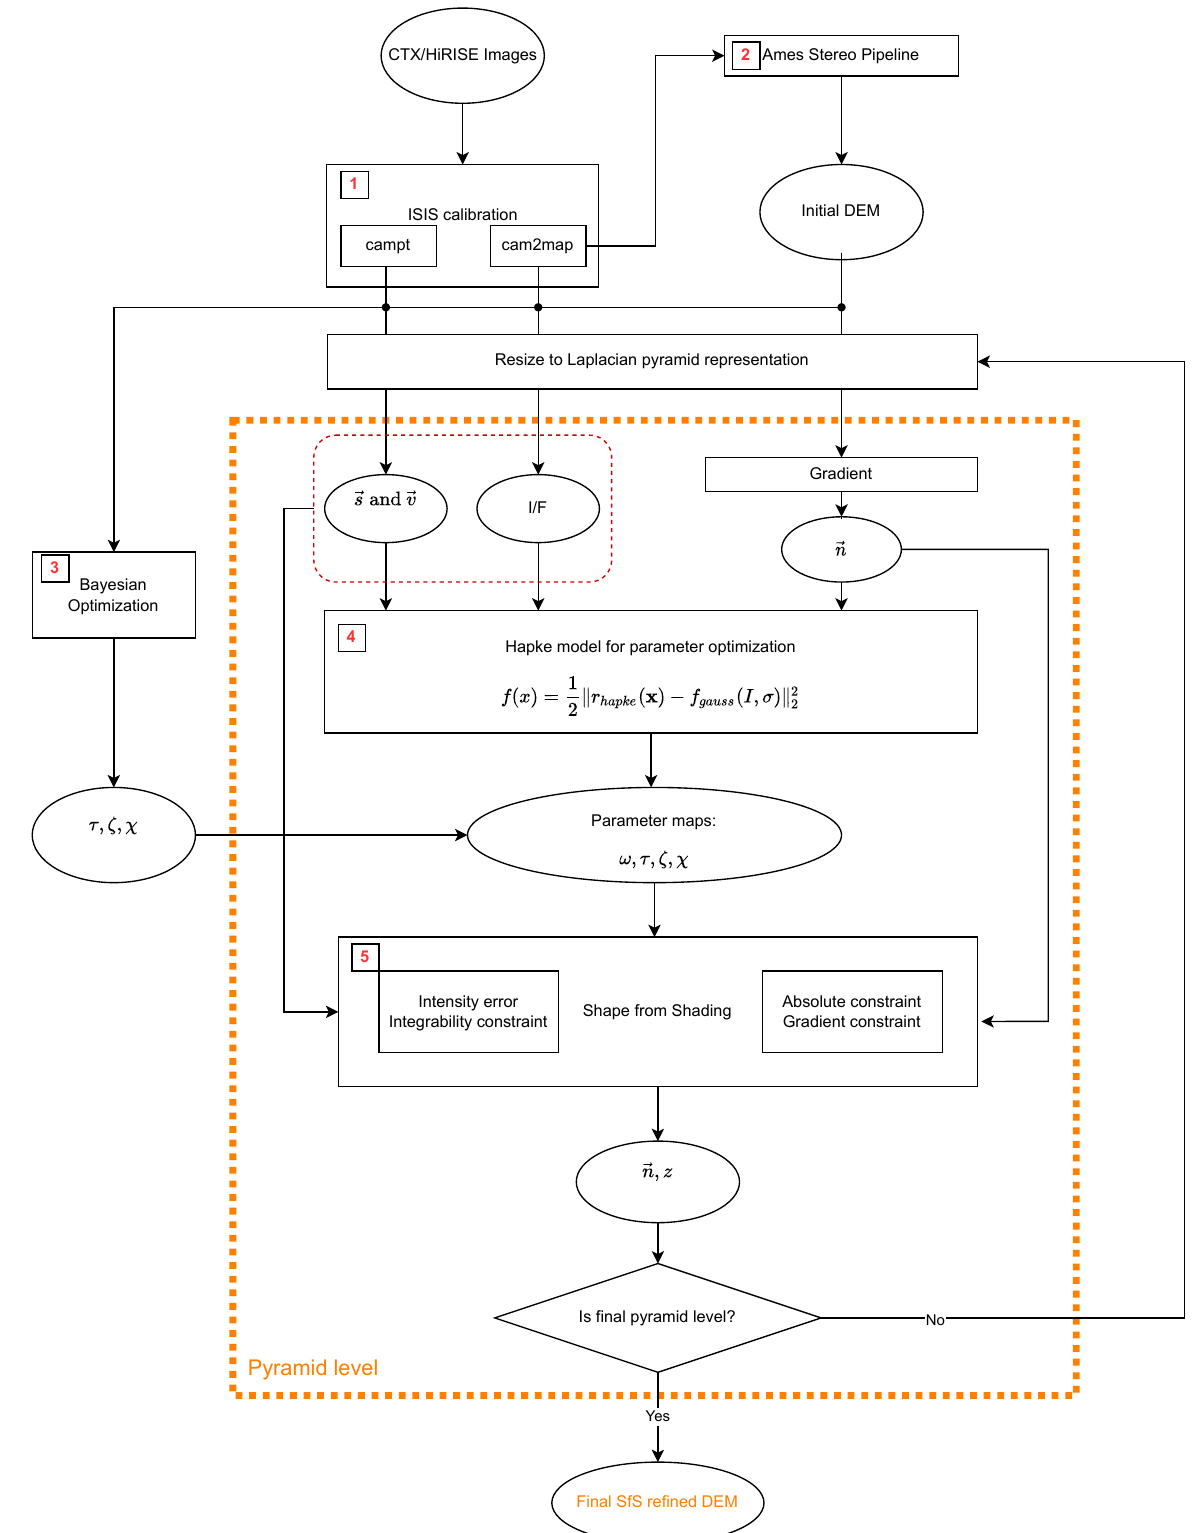
Figure 2. The complete SfS scheme. Steps in the orange dashed box are executed for each pyramid level at, e.g., 1/16, 1/8, 1/4, 1/2 and at full